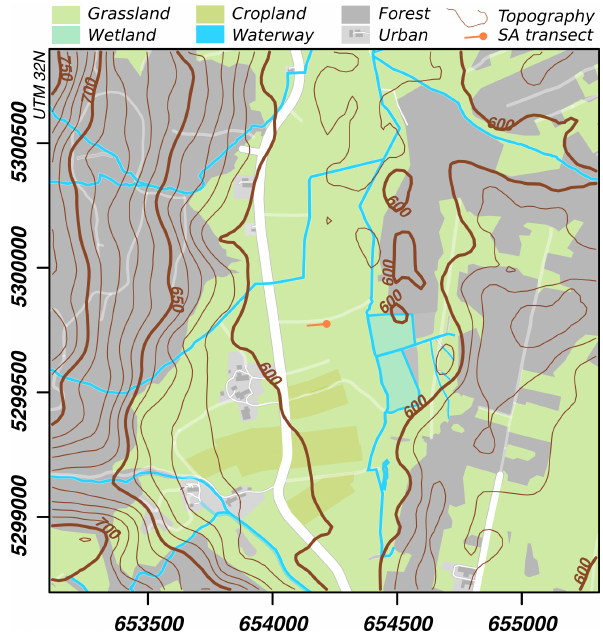
Figure 1. Location of the sonic anemometer (SA) transect at the DE-Fen field. Map modified from Fig. 1 in Zeeman et al.